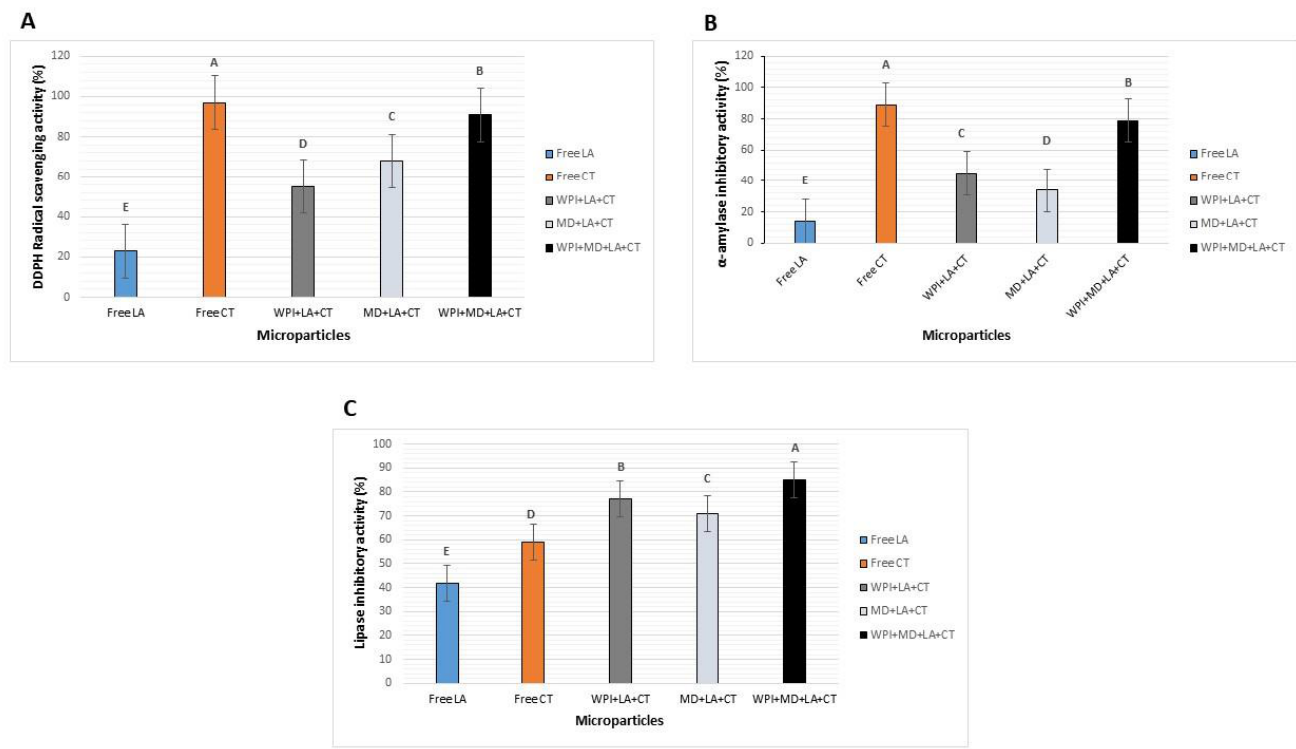
Figure 5. Microparticle functional properties: antioxidant activity ( A ), antidiabetic activity ( B ), and antiobesity activity ( C ). WPI + LA + CT: Whey protein isolate + L. acidophilus + Charantin; MD + LA + CT: Maltodextrin + L. acidophilus + Charantin; WPI + MD + LA + CT: Whey protein isolate + L. acidophilus + Maltodextrin + L. acidophilus + Charantin. Data represent means ± standard deviation. Different letters above each column represent significant differences in means ( p < 0.5).